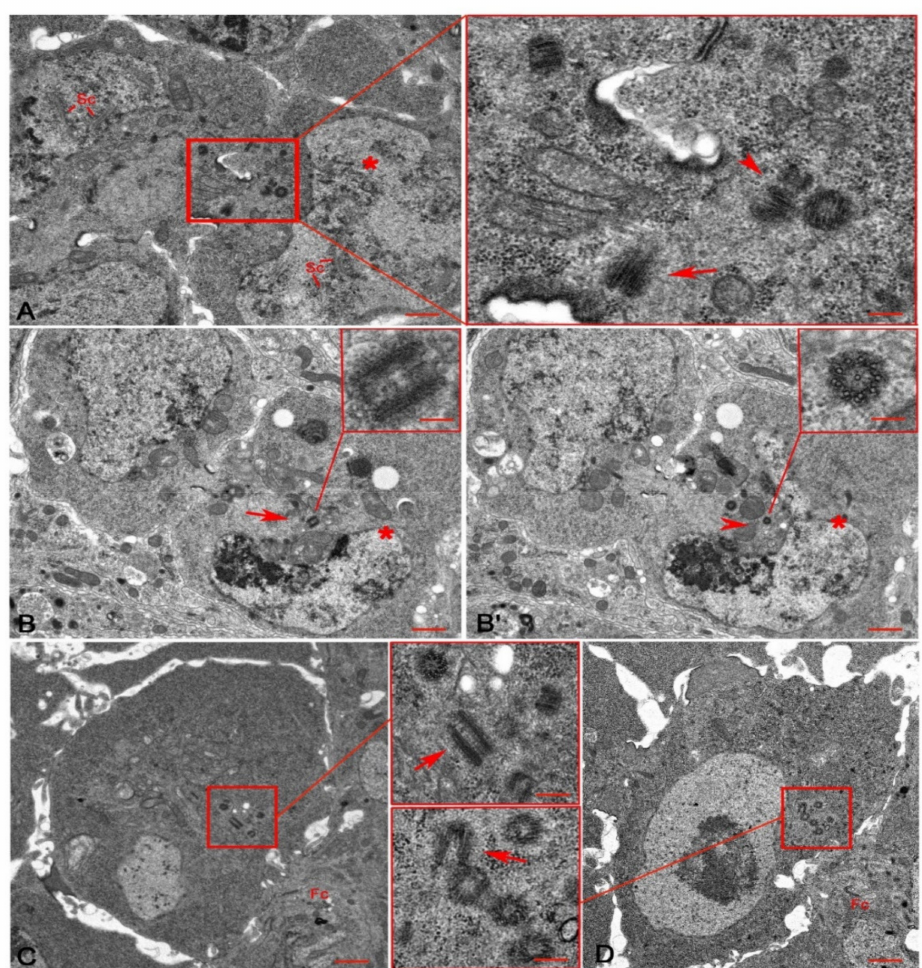
Figure 3. Region 2b ( A , B , B’ ) of the germarium and stages 2 ( C ) and 3 ( D ) of the vitellarium. ( A ) Cross section showing two pro-oocytes with distinct synaptonemal complexes (Sc), the posterior one is the pro-oocyte (asterisk); magnification highlights two orthogonal parent centrioles (arrowhead) and the grazing section of a longer one (arrow) within the oocyte cytoplasm. ( B , B’ ) Two consecutive serial sections of one oocyte (asterisks) showing an elongated centriole (arrow in B ) and its daughter (arrowhead in B’ ). The daughter centriole consists of mixed singlet and doublet microtubules (inset, B’ ). Cross sections of two oocytes during stages 2 ( C ) and 3 ( D ); magnification (insets, C , D ) shows centriole clusters in front of the follicle cells (Fc), arrows point to elongated centrioles. Bars: A – D , 1 µ m; inset A , 150 nm; inset B , B’ , 100 nm; insets C , D , 200